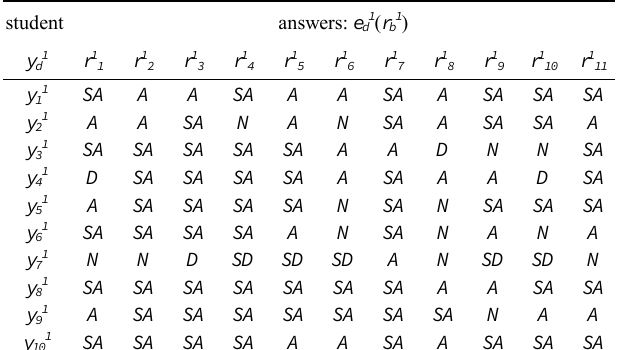
Table 3. Students’ answers to the questionnaire R 1